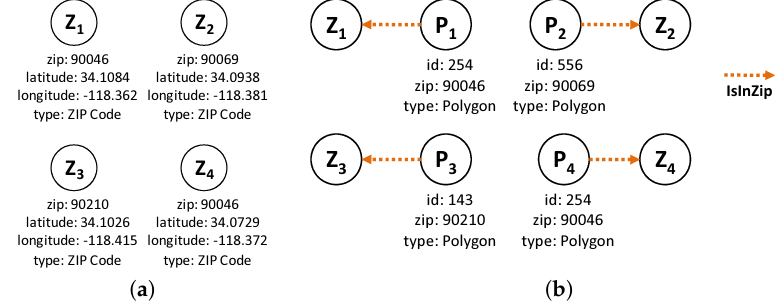
Figure 7. Building ZIP codes—Steps 1 and 2.1. ( a ) Step 1; ( b ) Step 2.1.